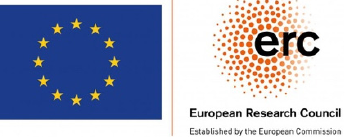
Table S1: Characteristics of the 25 metabolomics studies conducted in children, Table S2: PubMed database